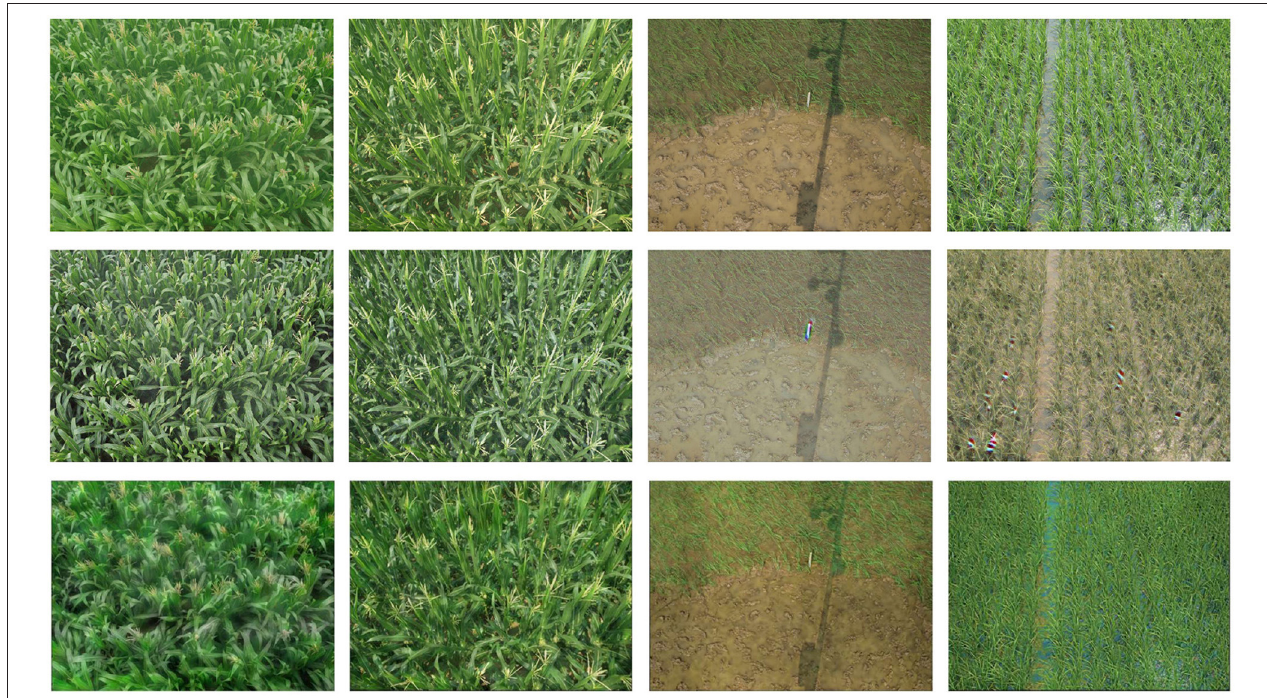
FIGURE 10 | Visualizations of style transferred images with different image-level UDA methods. From top to bottom alternating: source domain image, transferred images by PCEDA and transferred images with FDA.